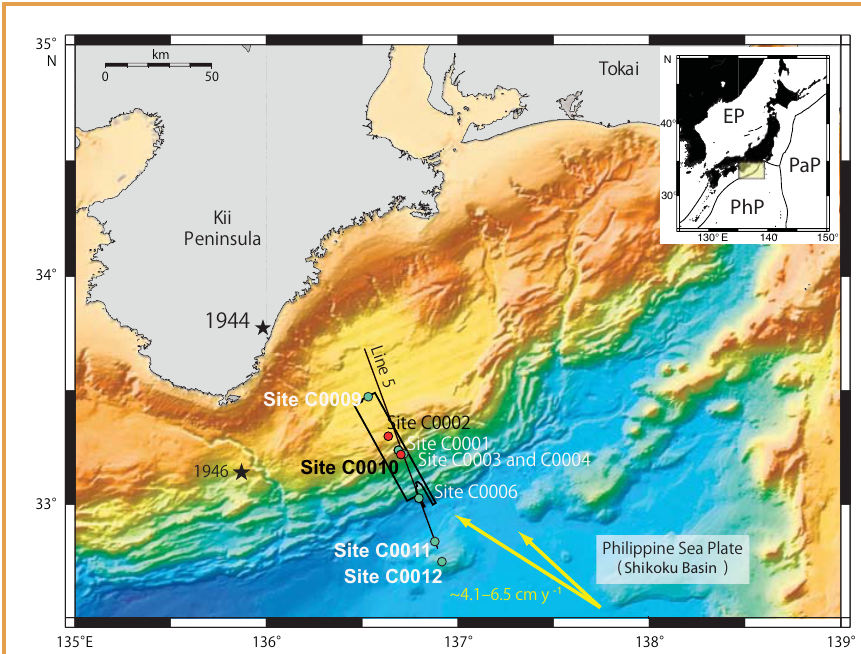
Figure 1. A map of the study area depicting Sites C0002 and C0010 with red circles. The locations of the other NanTroSEIZE sites are shown (green circles), while the inset shows the site location in reference to Japan, and the respective tectonic plates surrounding Japan (EP=Eurasian Plate, PaP=Pacific Plate, PhP=Philippine Plate). The yellow arrows depict the relative movement (4.1–6.5 cm y -1 ) of the Philippine Plate. The elongated box depicts the limits of the 3D survey area, while Line 5 depicts KR0108-5, a 2D seismic survey